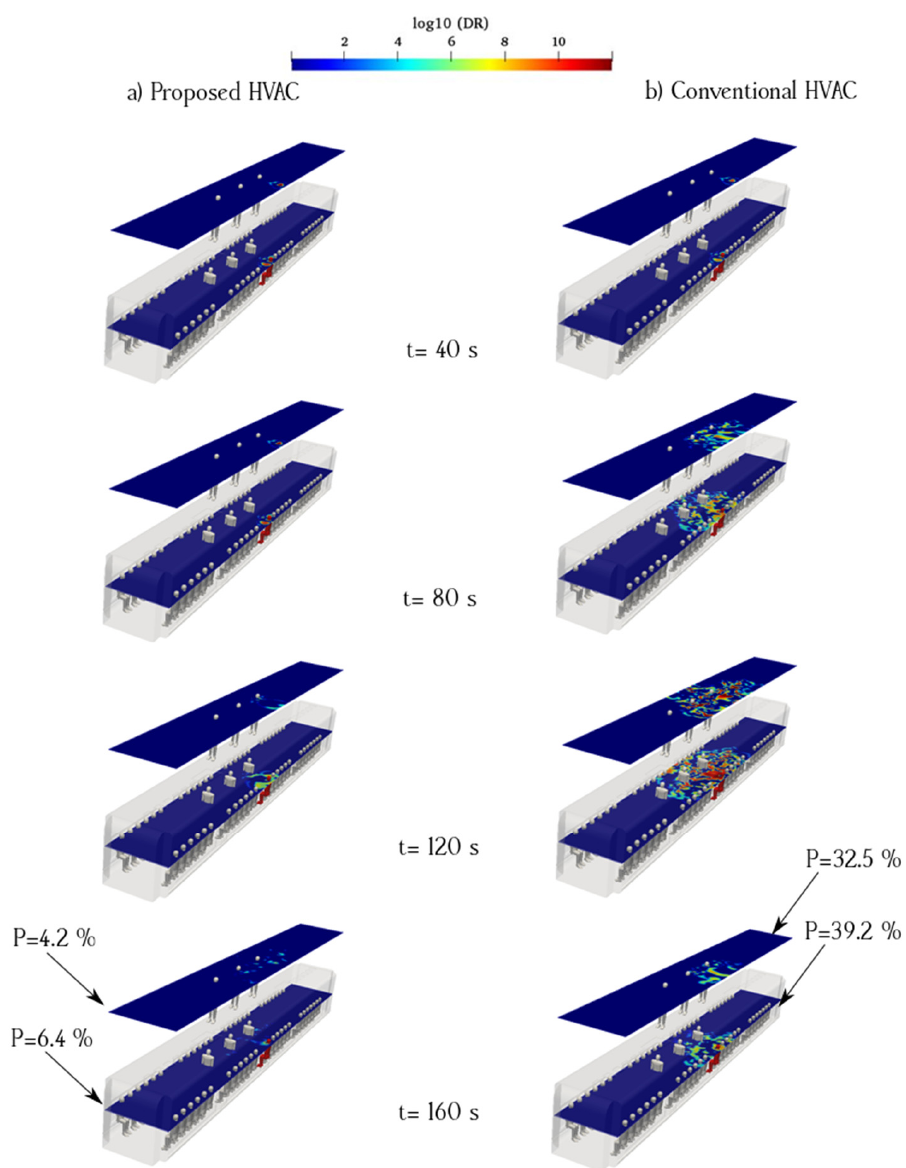
Figure 10. Time evolution of the counters of log 10 (DR) when the infected individual was sitting near the supply air and recirculated ducts of the proposed ( a ) and conventional ( b ) HVAC systems (Case 2).